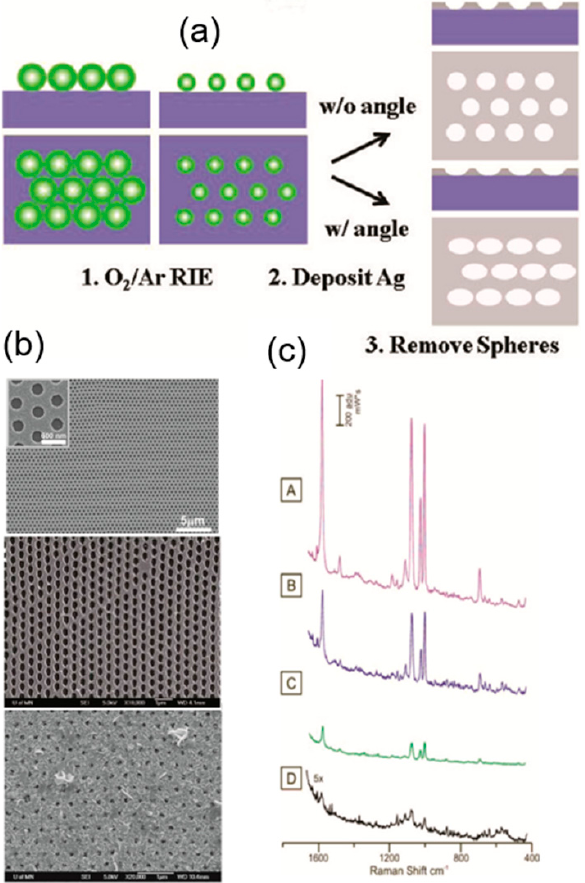
Figure 3. ( a ) Schematic representation of process steps for fabricating nanohole arrays using nanosphere lithography. ( b ) SEM images of (top) the resulting large area (~30 × 30 µm 2 ) single crystalline hexagonal nanohole array, (middle) an elliptical nanohole array (60° tilt angle) after nanosphere removal, and (bottom) after 4 min Ag electroless plating onto the nanohole array. ( c ) SERS spectra of ( A ) 4 min Ag plated nanohole array, ( B ) 4 min Ag plated flat silver film, ( C ) a standard nanohole array, and ( D ) 5× a flat silver film. All substrates were exposed to 1 mM benzenethiol prior to SERS measurements. P = 0.32 mW, t = 180 s, and λ max = 532 nm. Reproduced ( a , c ) and adapted ( b ) with permission from Reference [56], Copyright 2009, American Chemical Society.